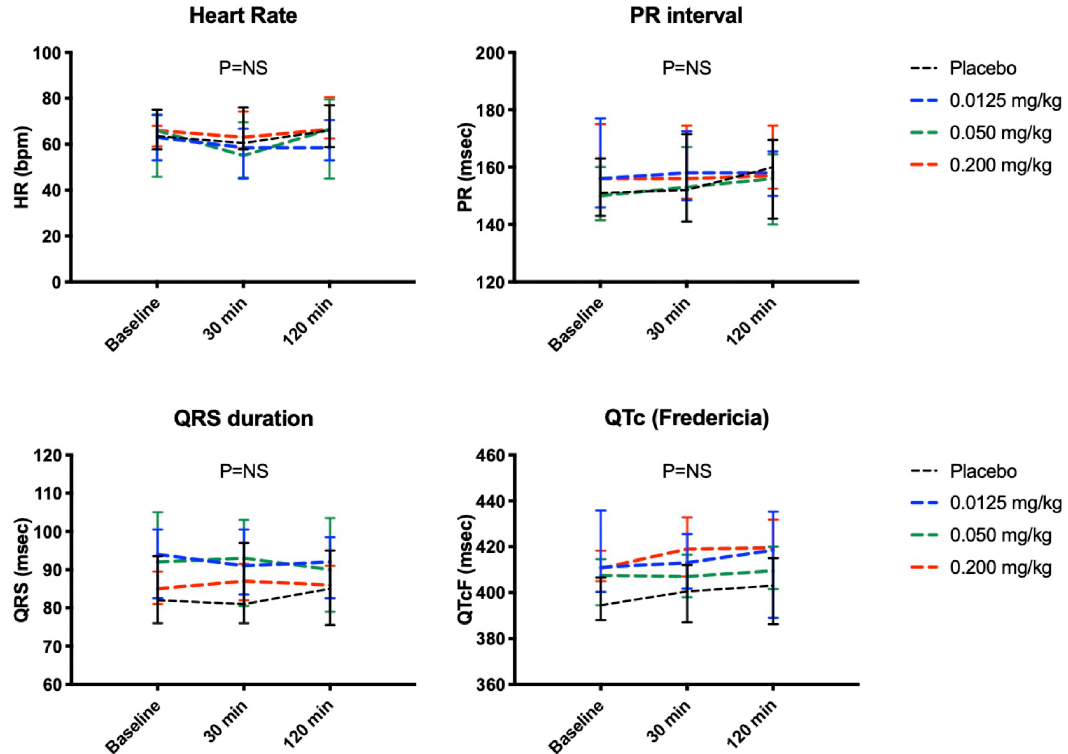
Fig 5. Effects of SP16 on cardiac